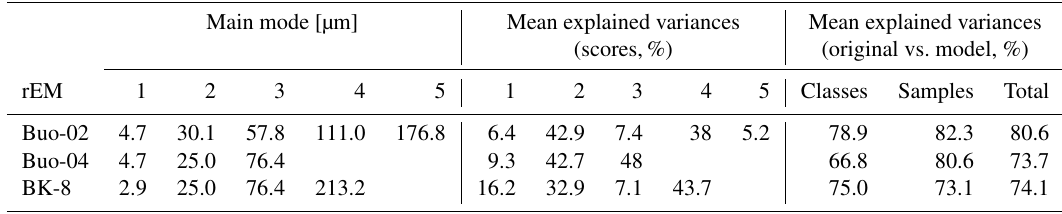
Table 1. Comparison of robust grain-size end-members, their explained variances of scores, and performance of original vs. modelled data (using the mean robust end-members, R 2 × 100).